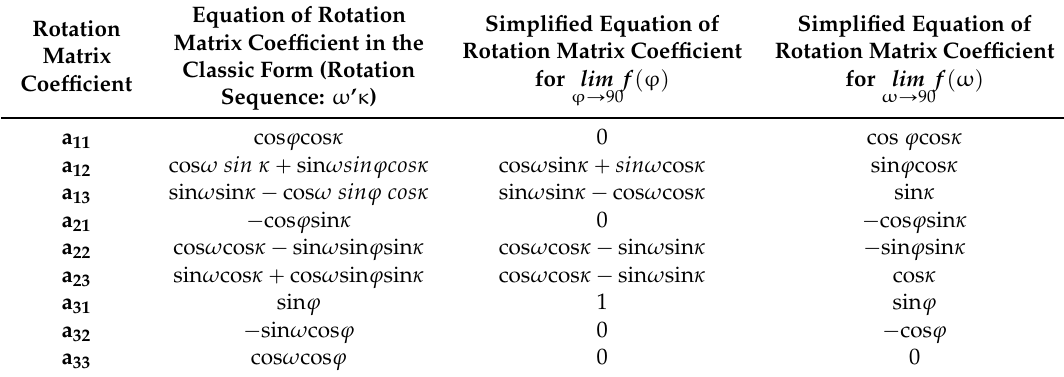
Table 1. Simplified rotation matrix coefficient equations when φ = 90 ˝ or ω = 90 ˝